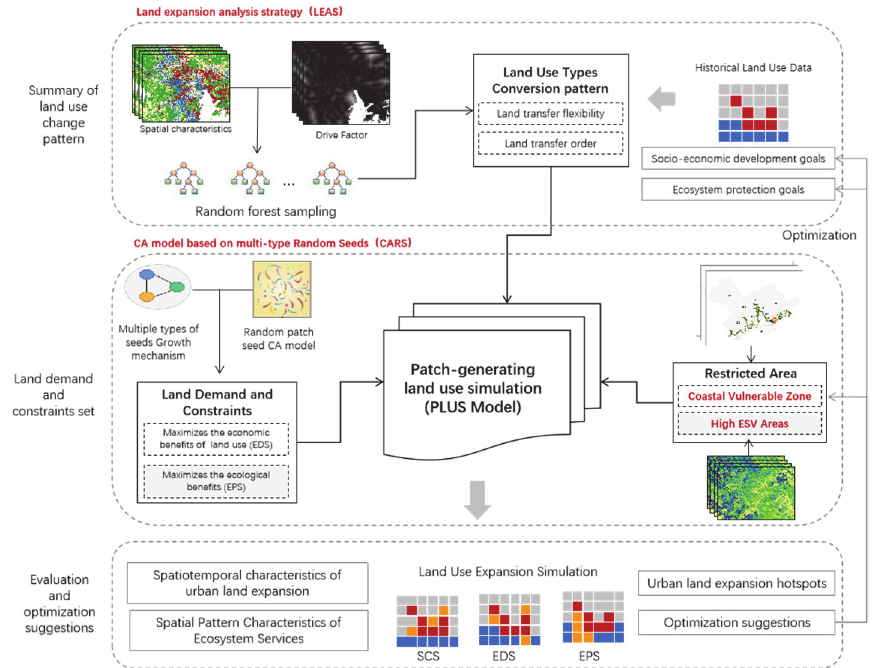
Figure 3. Simulation model framework of urban expansion in a multi-scenario based on ES.